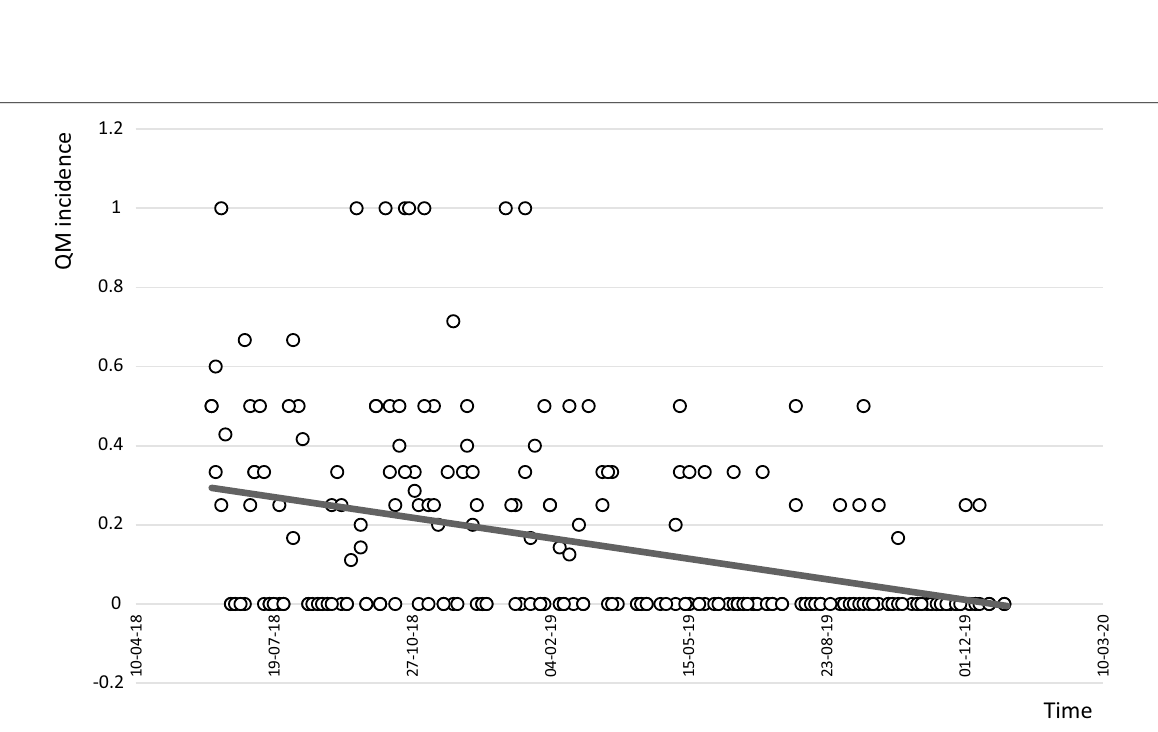
Fig. 3 Incidence of QM events over time. Each dot represents one MDC at a specific time of the intervention period. The QM incidence (Y-axis) shows the number of QM events per examination presented for each of those MDCs. QM events decreased significantly by 73.6% from the first ( n 109/476) to the second half ( n 30/497) of the intervention period ( p < 0.0001) as reflected by the trend line. This significant decrease in QM = = events over time was confirmed by linear regression ( p 0.0001) after testing for respective =